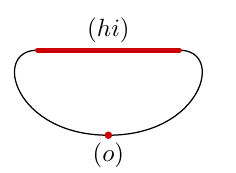
Figure 5. Example of a discrete vector field on the ring.